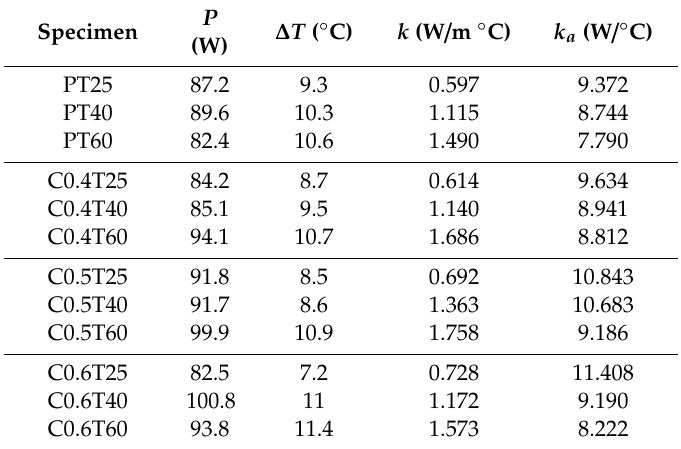
Table 3. Thermal conductivities of test specimens by average power and temperature gradient.